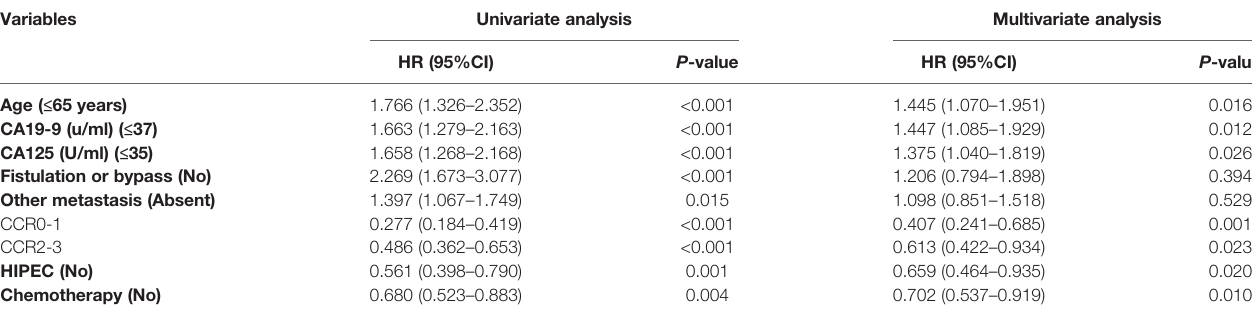
TABLE 2 | Univariate and multivariate analyses of the 277 CRC patients with S-PM in the development group.